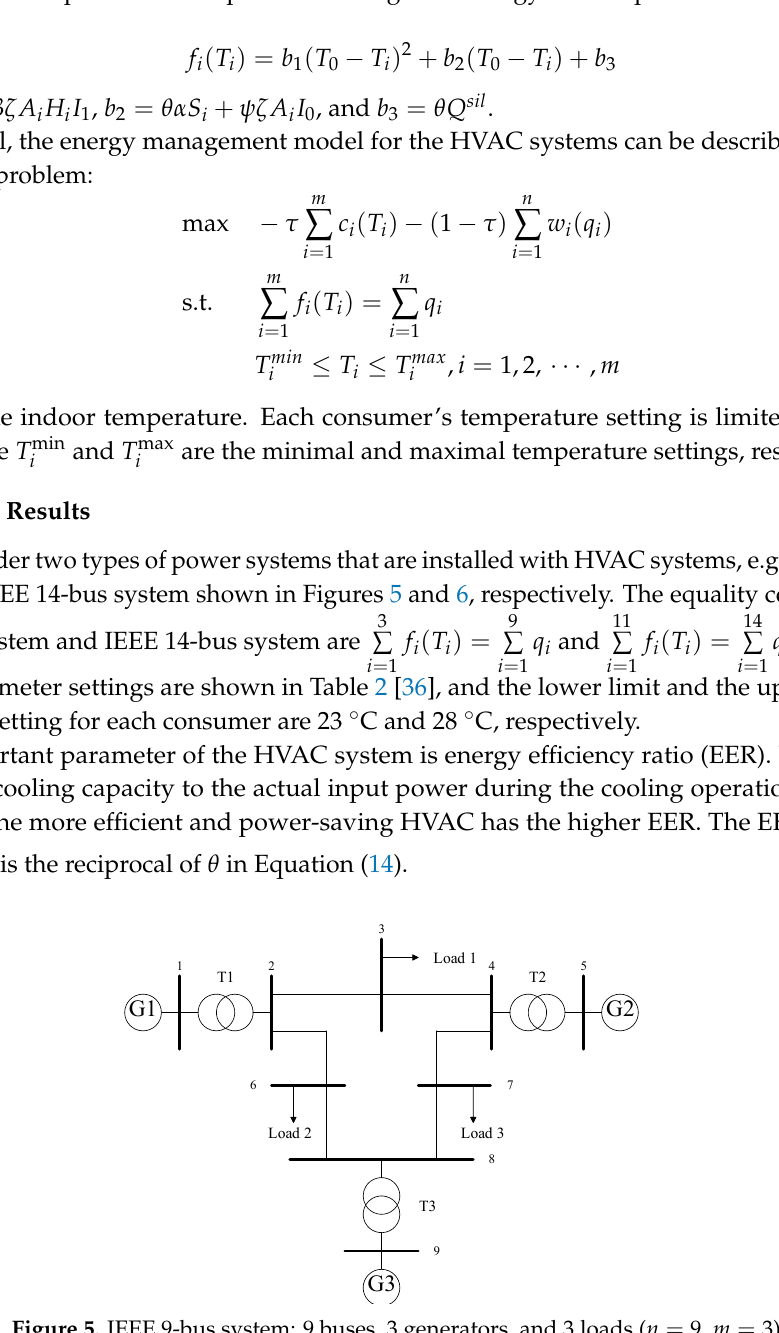
Figure 5. IEEE 9-bus system: 9 buses, 3 generators, and 3 loads ( n = 9, m =